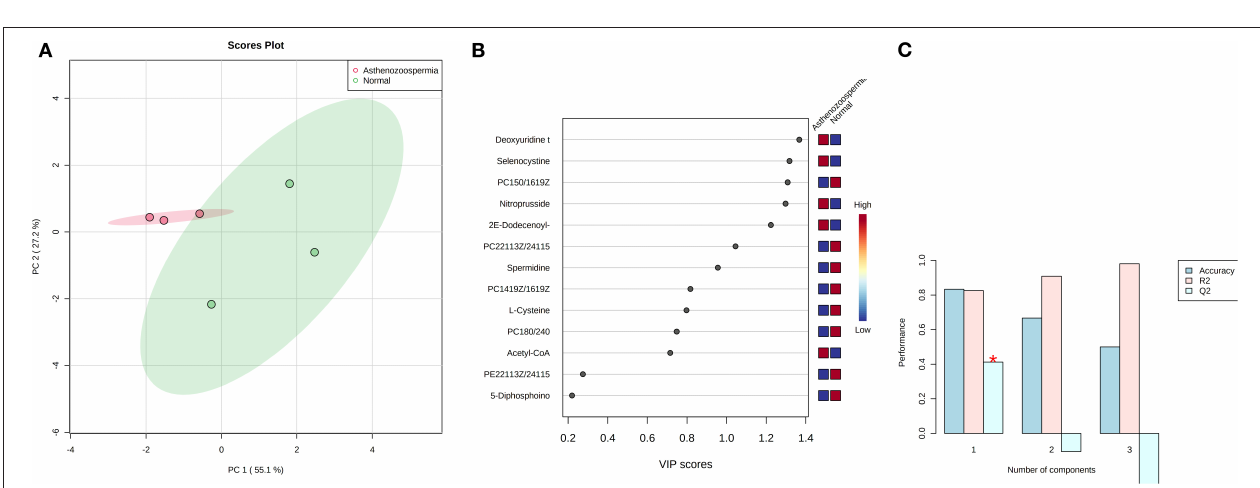
FIGURE 3 | PLS-DA based on score plot (A) and Heat map (B) of Vip score of significant metabolites in spermatozoa of astheno-oligozoospermia bulls. (C) Cross validation of PLS-DA based on score plot of significant metabolites in spermatozoa of astheno-oligozoospermia bulls where Q2 is an estimate of the predictive ability of the model, and is calculated via cross validation. In each CV, the predicted data are compared with the original data, and the sum of squared error is calculated. The prediction error is summed over all samples (Predicted residual sum of squares or PRESS). For convivence, the PRESS is divided by initial sum of the squares and subtracted from 1 to resemble the scale of the R2. Good prediction will have low PRESS or high Q2. It is also possible to have negative Q2, which means that the model is not at all predictive or overfitted. as compared with normozoospermic bulls. On the other hand, and 2E-dodecenoyl-CoA. The relative concentration of principal component analysis ( Supplementary Figure 6A ) corresponding metabolites based on VIP score also revealed revealed the variance of significant features, whereas higher levels of selenocysteine, deoxyuridine triphosphate, and nitroprusside in spermatozoa of astheno-oligozoospermic bulls correlation plot analysis showed the positive correlation